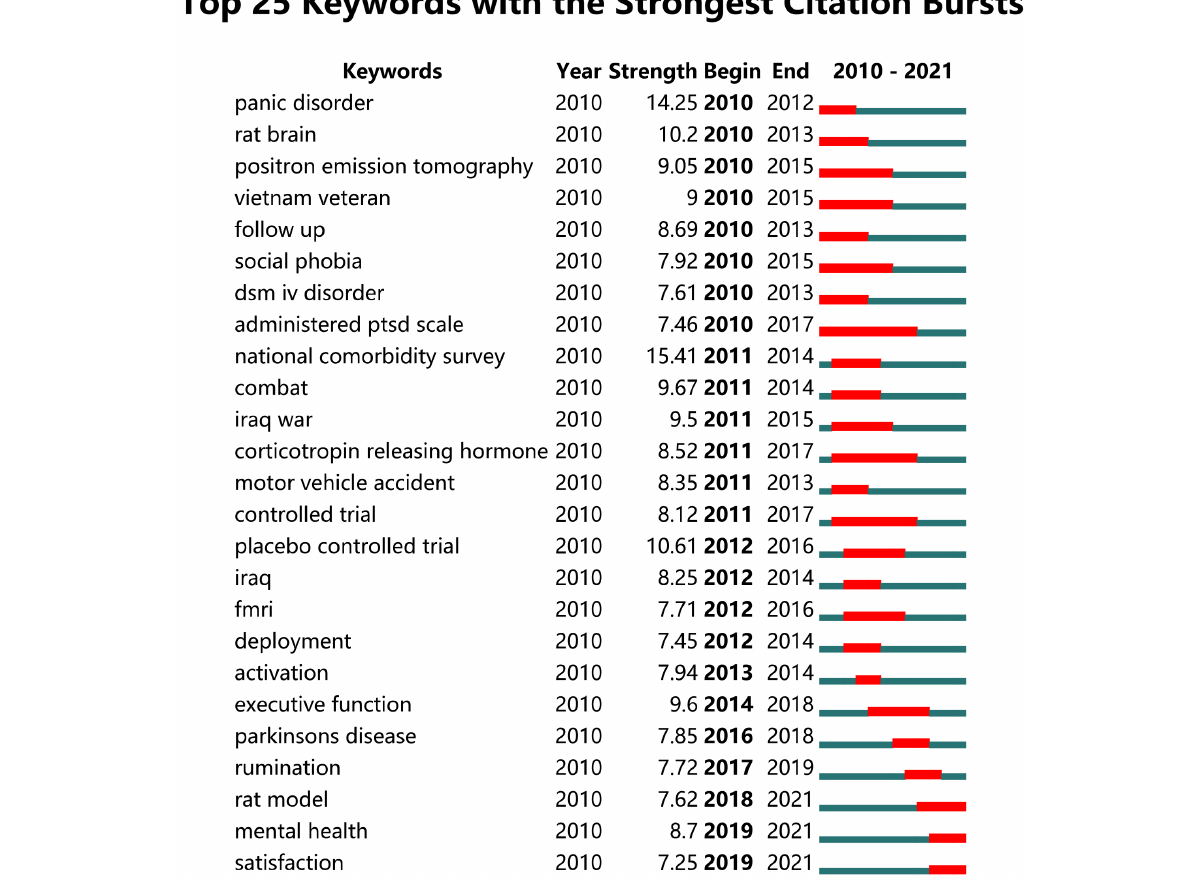
FIGURE 5 The top 25 keywords with the strongest citation bursts.